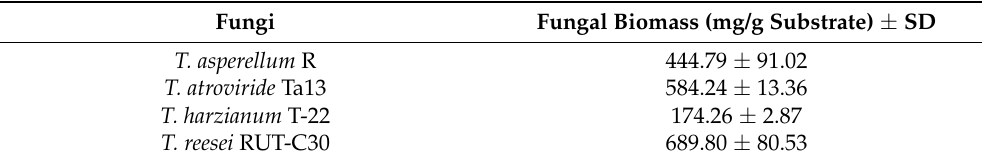
Table 4. Biomass quantification of Trichoderma spp. expressed as mycelium per gram of substrate (mean value ± SD).